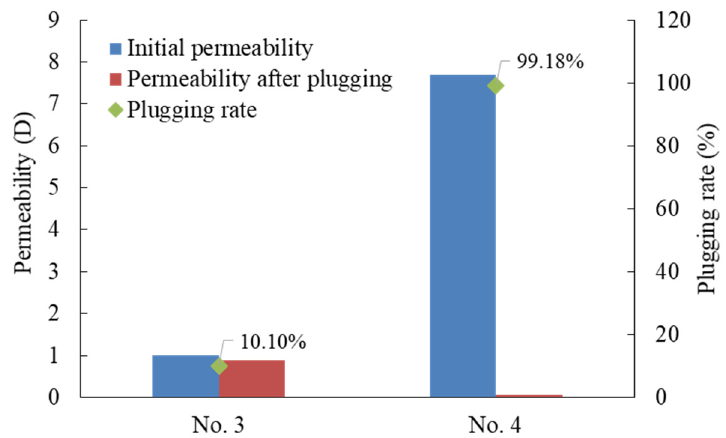
Figure 10. Plugging rate with different sand-packs in the parallel model.